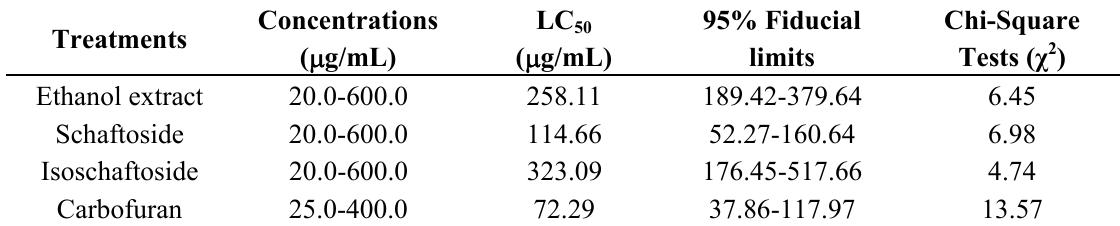
Table 1. Nematicidal activity of ethanol extract of Arisaema erubescens and isolated flavone-C-glycosides against Meloidogyne incognita